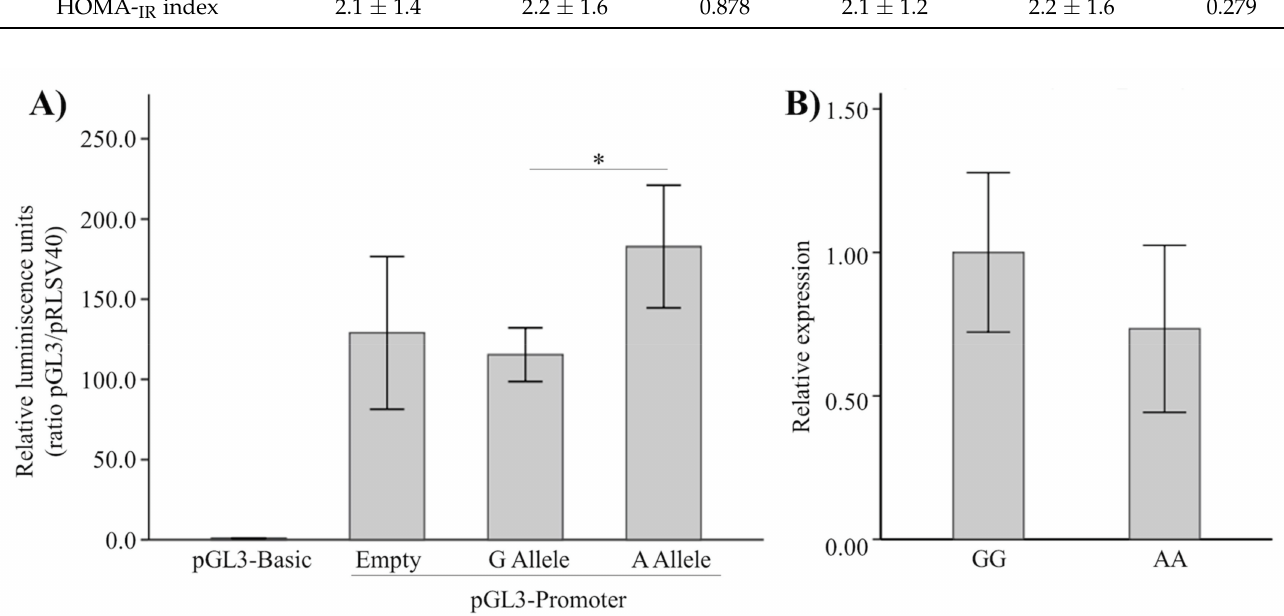
Figure 1. ( A ) Relative luciferase activity in MC3T3 cells. Values were normalized against the luciferase activity of Renilla vector pRLSV40. The G and A allele vectors were made in pGL3-Promoter by cloning a 336 bp region containing the SNP rs87939. Alleles G and A showed a statistically significant difference in luciferase activity levels ( p -value = 0.007). ( B ) CTNNB1 expression (mean ± SE) in primary OBs according to genotype of SNP rs87939. Gene expression was calculated with the 2 − ∆∆ Ct formula, with ∆ Ct representing the difference between the CTNNB1 Ct and the mean of the housekeeping genes Cts ( ACTB and GAPDH ). Values were normalized for gene expression of the GG genotype. * p -value =